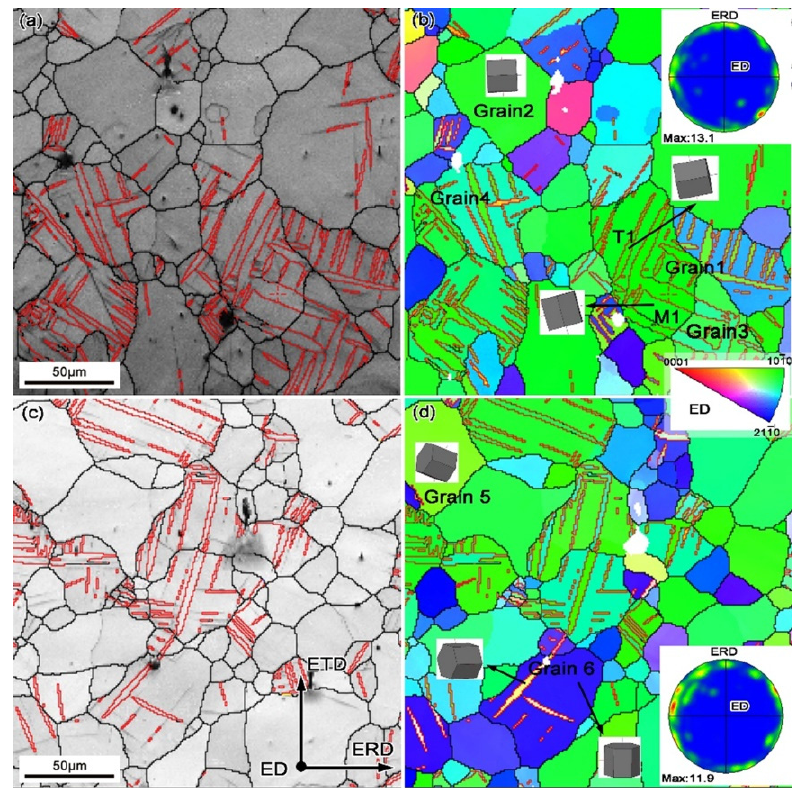
Figure 3. Typical EBSD results of 1.3% pre-strained and annealed samples (ERD1.3CA) in band contrast ( a , c ) and inverse pole figure maps ( b , d ). Boundaries of {10 12} twins are colored in red. The corresponding (0001) pole figures are inserted.